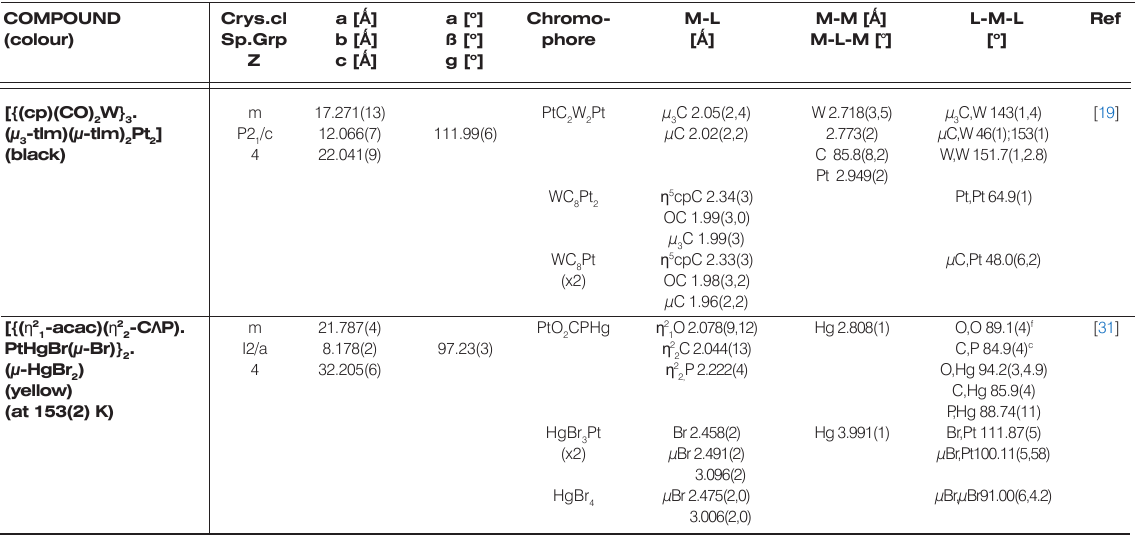
(cp)(µ -tlm)] Pt] 2 3 2